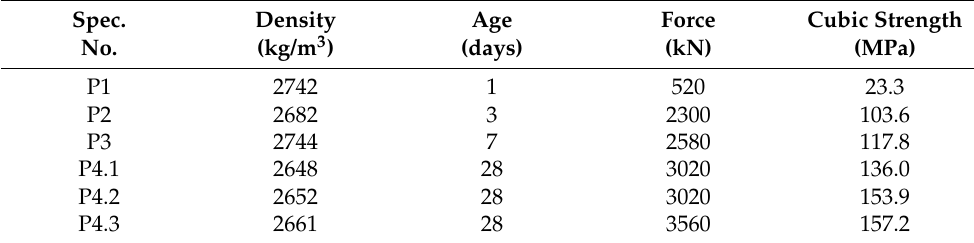
Table 2. Results of UHPFRC cube strength tests on samples of batches P1–P3 and P4.1–P4.3.